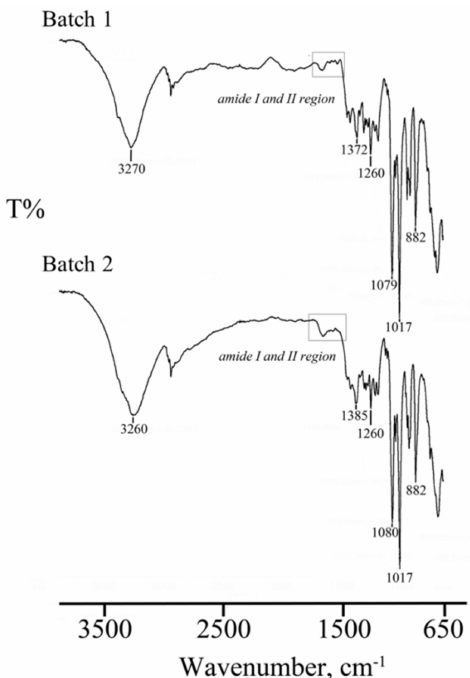
Figure 5. FTIR spectra of two lyo-secretome batches (batch 1 and batch 2). In the picture are evidenced the regions corresponding to Amide I and Amide II stretching vibrations at 1653 cm − 1 and 1547 cm − 1 , respectively, confirming the presence of EVs and proteins in the lyophilized products.